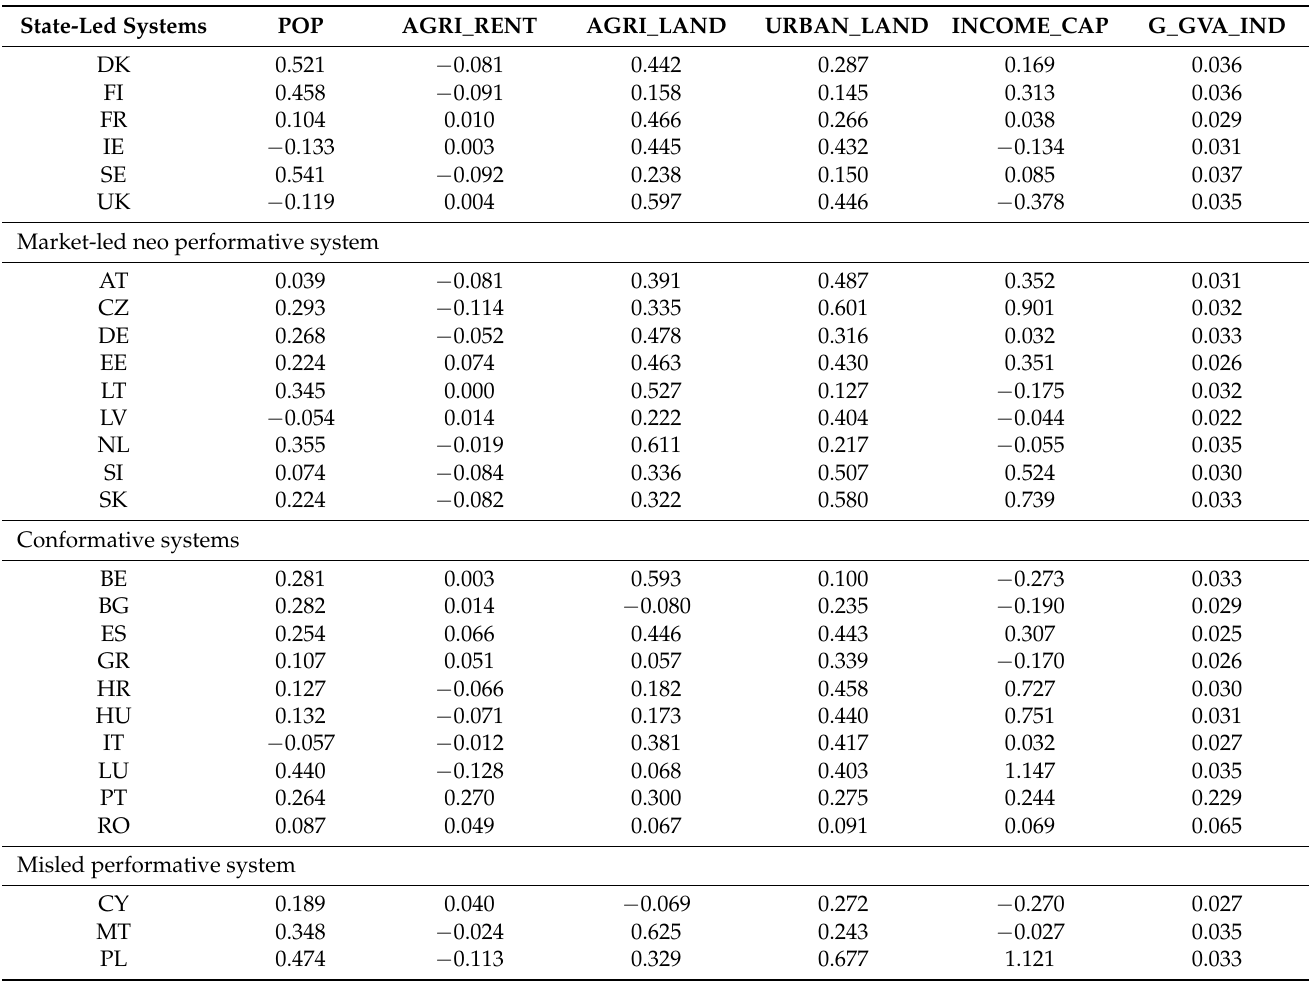
Table 6. Average values of estimated coefficients (from MGWR model) across countries applying different planning